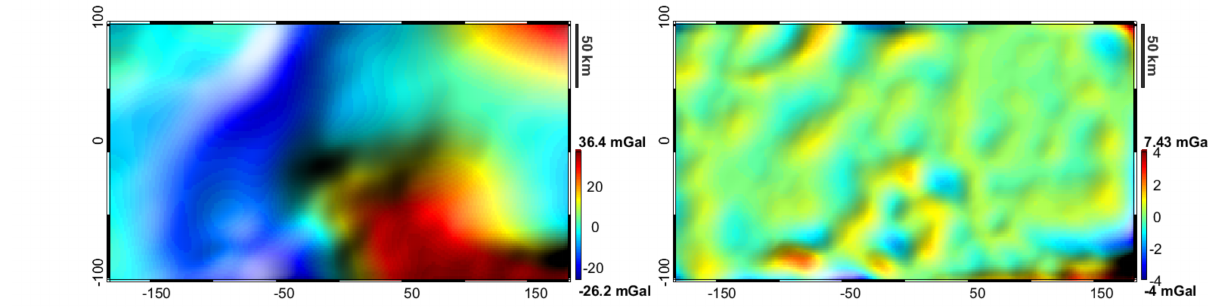
Figure 7. Scenario 1 inversion: Difference between the gravitational effect of the true and a priori model ( left ) and of the true and the a posteriori model ( right ).